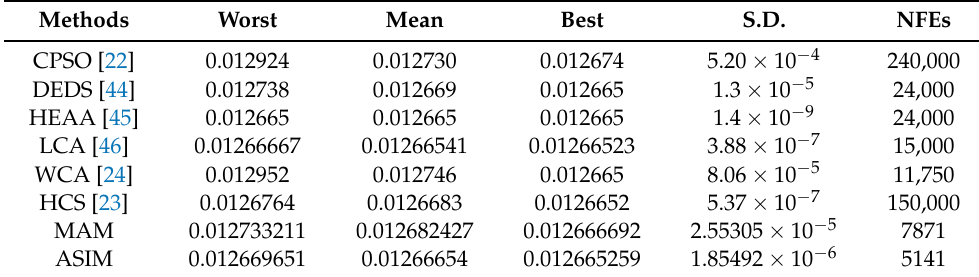
Table 8. Comparison of statistical results given by different algorithms for the tension/compression spring design optimization